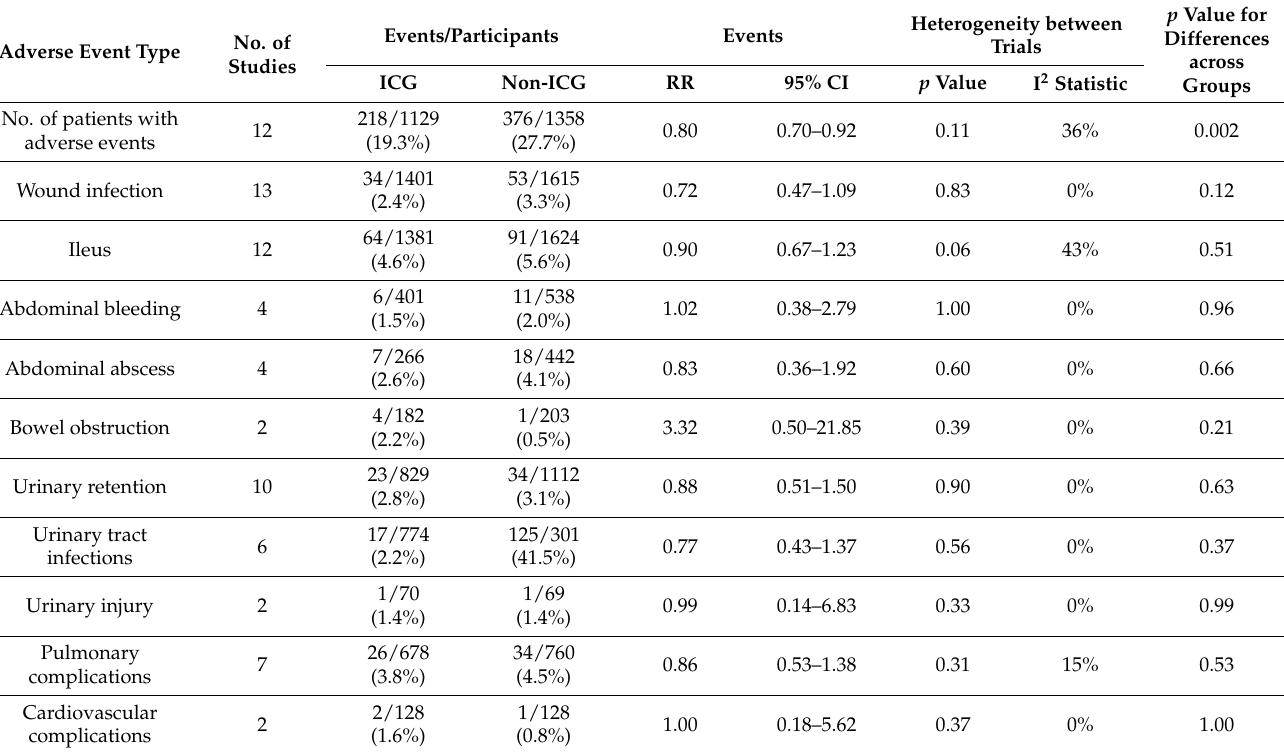
Table 2. Pooled analysis of adverse events in the included